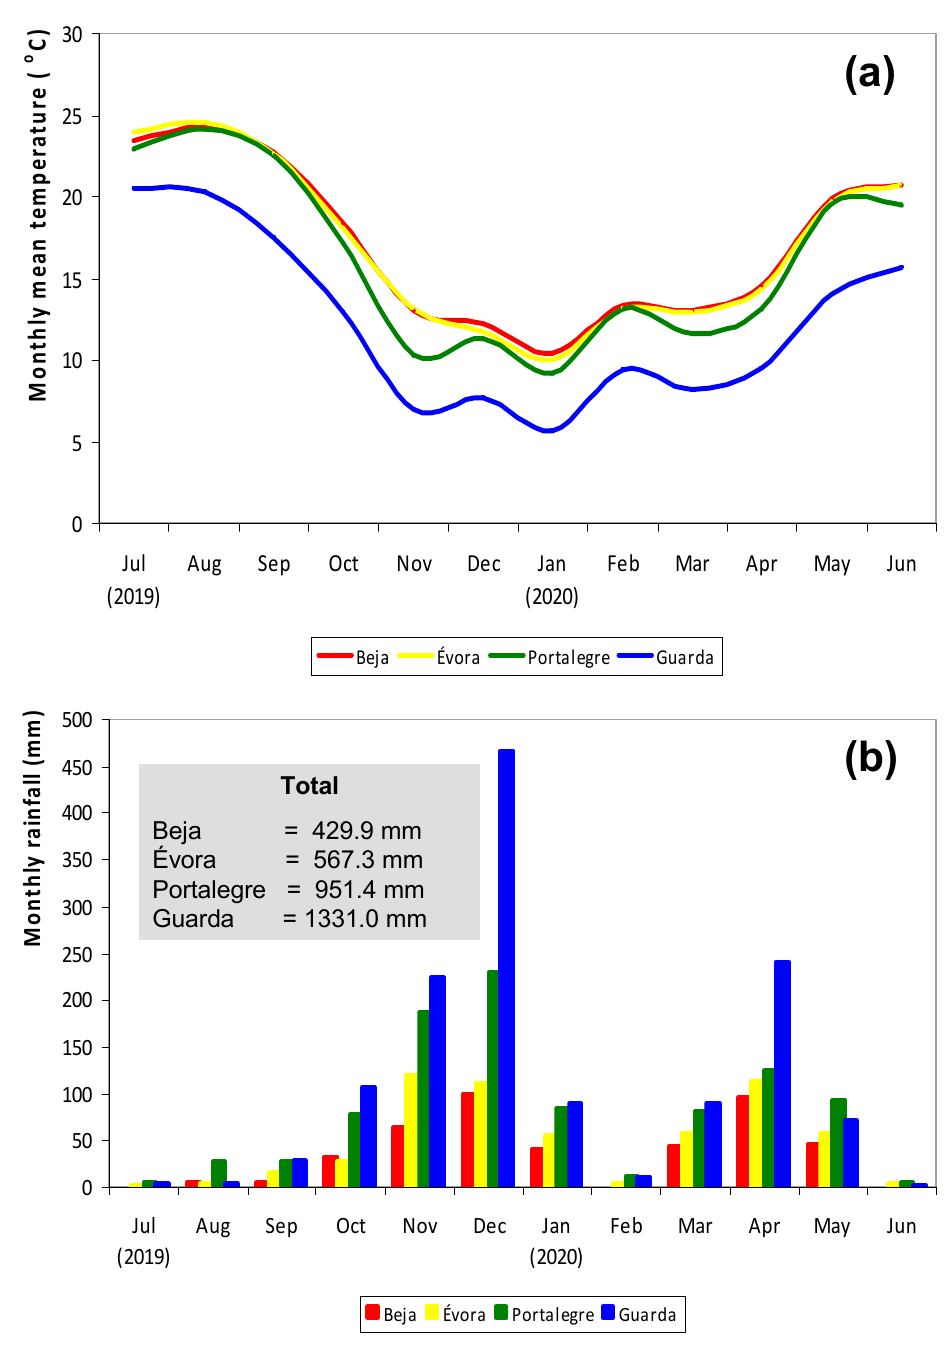
Figure 3. Thermopluviometric graphs of the Beja, Évora, Portalegre, and Guarda Portuguese districts between July 2019 and June 2020 (source: Portuguese Institute of Sea and Atmosphere). ( a ) monthly mean temperatures ( b ) monthly rainfall.